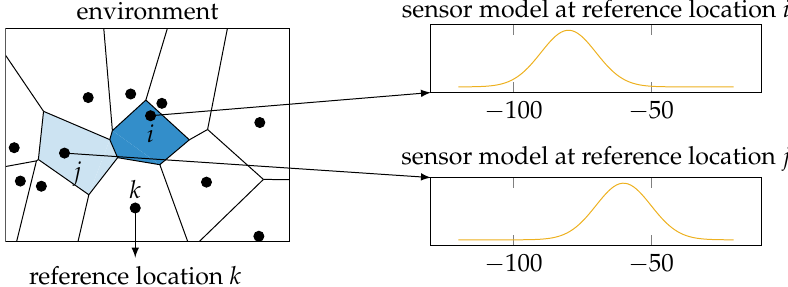
Figure 1. The environment in Wi-Fi fingerprinting is split up into discrete spaces, namely the nearest locations to a single reference location. The sensor model’s dependency on the location parameters changes discontinuously as it is determined by the training measurements at the reference